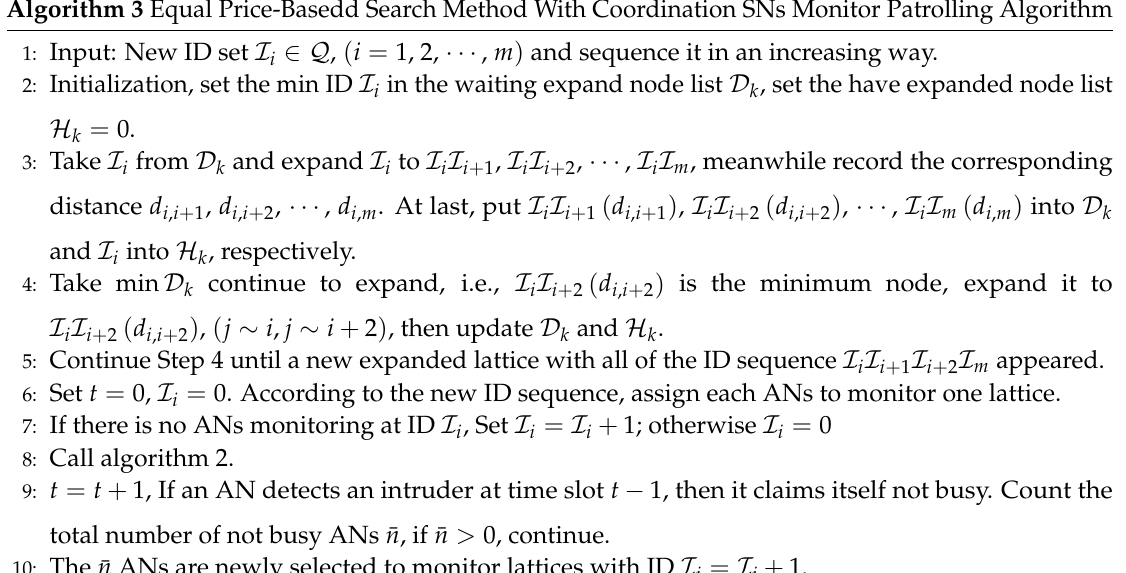
Algorithm 3 Equal Price-Basedd Search Method With Coordination SNs Monitor Patrolling